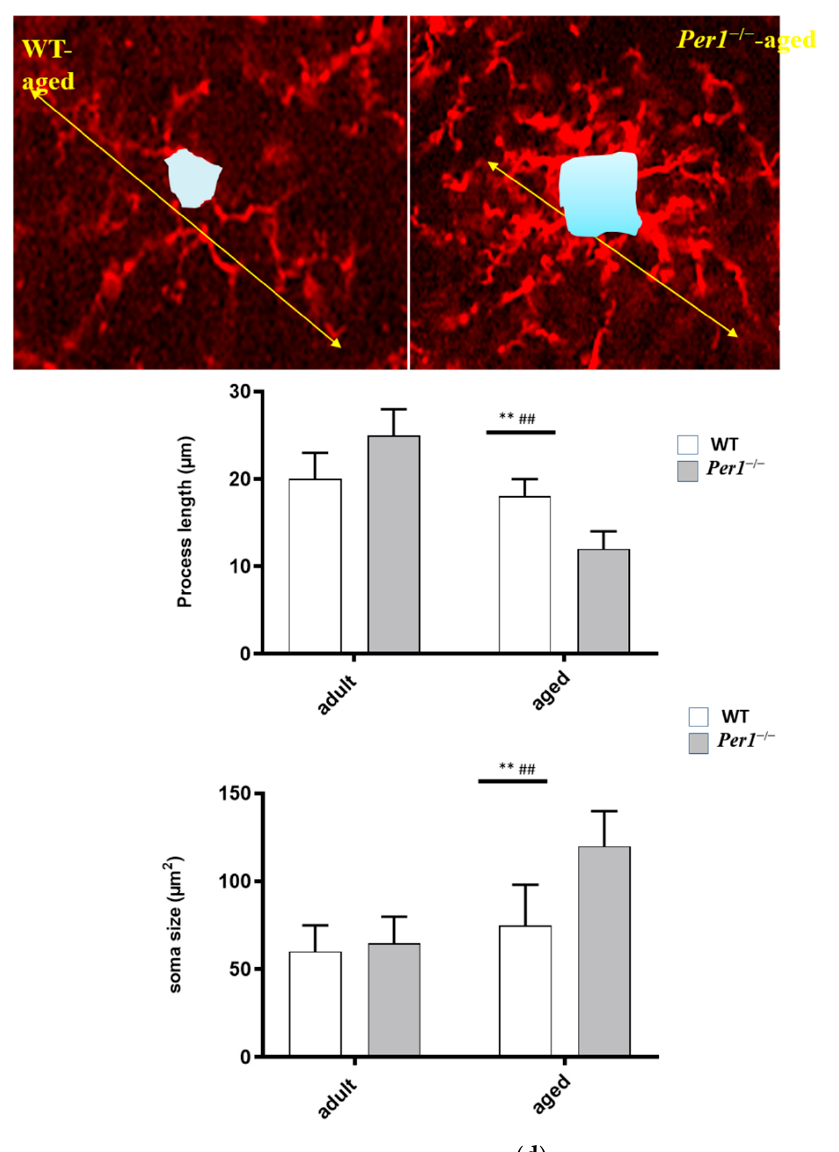
Figure 3. ( a – d ): ( a ) A homogenous distribution of hippocampal microglial cells is lost in the aged brain. Histological sections were taken from adult WT (3 months), adult Per1 − / − -mice (3 months), aged WT (24 months) and aged Per1 − / − -mice (24 months). Representative Iba-1 immunostained sections are shown for each age group. The comparison of clustered microglia across age groups revealed significant differences in their clustering pattern, with an increased number of microglia in close proximity to each other in aged mice. Scale bars 100 µ m. ( b ) Histological sections were taken from aged WT (24 months) and aged Per1 − / − -mice (24 months). The comparison of clustered microglia in the corpus callosum revealed similar differences in their clustering pattern, with an increased number of microglia in close proximity to each other in aged Per1 − / − -mice. Scale bar 100 µ m. ( c ) Densitometric analysis of Iba1 immunoreactivity in the hippocampus of WT (white scale) and Per1 − / − -mice (grey scale). *** p < 0.001 and ### p < 0.001. ( d ) Aged Per1 − / − -mice show significant alterations of microglia morphology, including soma volume increase and short- ening of processes. Significant differences between means were statistically assessed by ANOVA. ** p < 0.01 and ## p < 0.01 were considered statistically significant. * Difference between the age groups; # differences between